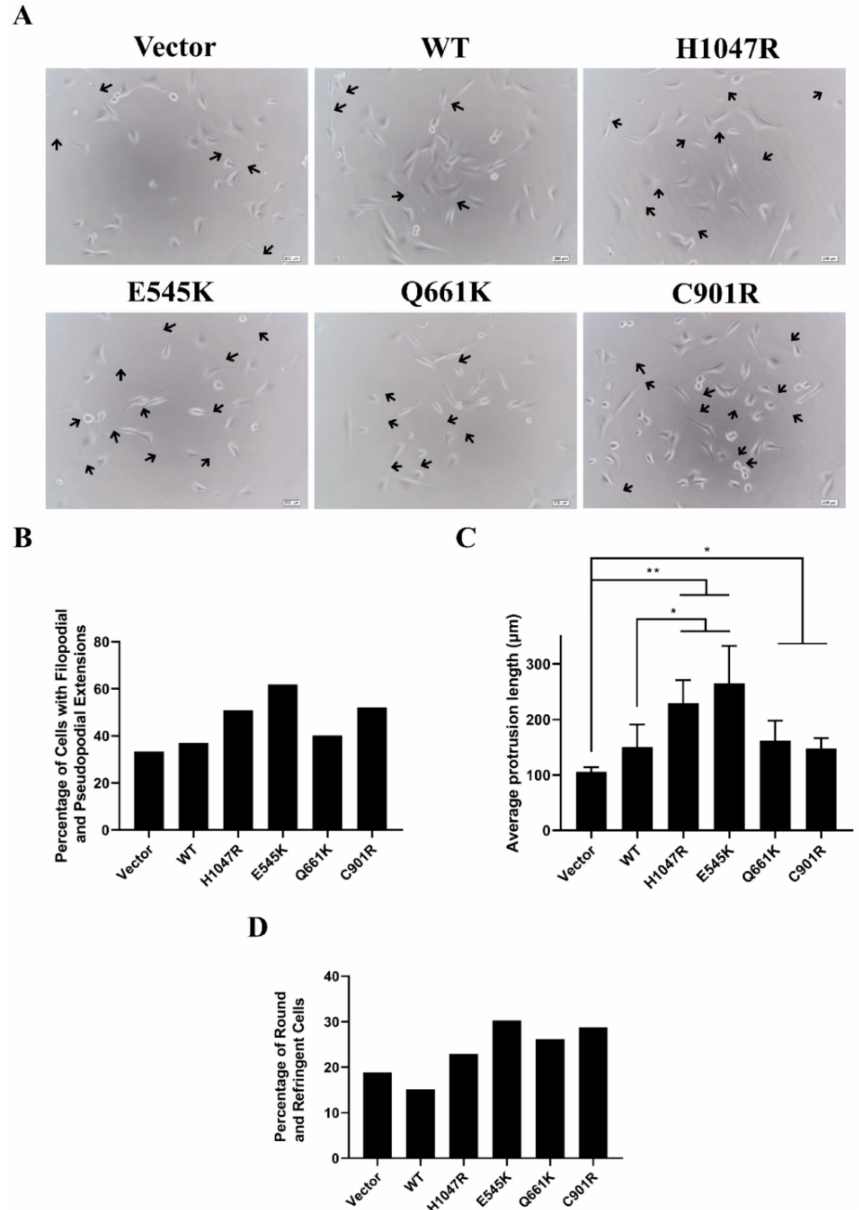
Figure 2. Altered gross morphology of NIH3T3 cells overexpressing PIK3CA mutants. ( A ) Prominent cellular protrusions (black arrows) were observed in cells overexpressing PIK3CA mutants. Scale bar: 200 µ m. ( B ) NIH3T3 cells with prominent cellular protrusions were counted and divided by total number of fibroblasts. ( C ) The lengths of cellular protrusions were measured from the center of the nucleus to the tip of the extension. The total length was then divided by the total number of fibroblasts. ( D ) Cells showing decreased size, roundedness, and birefringence were quantified and divided by the total cell count. The percentage of birefringent cells and cells with cellular protrusions, as well as the average length of these protrusions, increased in cells overexpressing the PIK3CA mutations. Data presented are representative of three independent trials in triplicate, and expressed as mean ± standard deviation. * p < 0.05 and ** p < 0.01. WT: wild type. PIK3CA: phosphatidylinositol 3-kinase, catalytic subunit